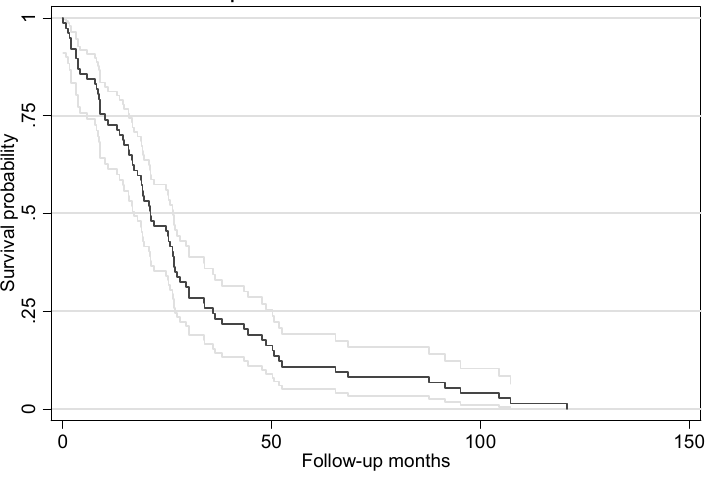
Figure 1 – Kaplan Meier estimates of the survival function.